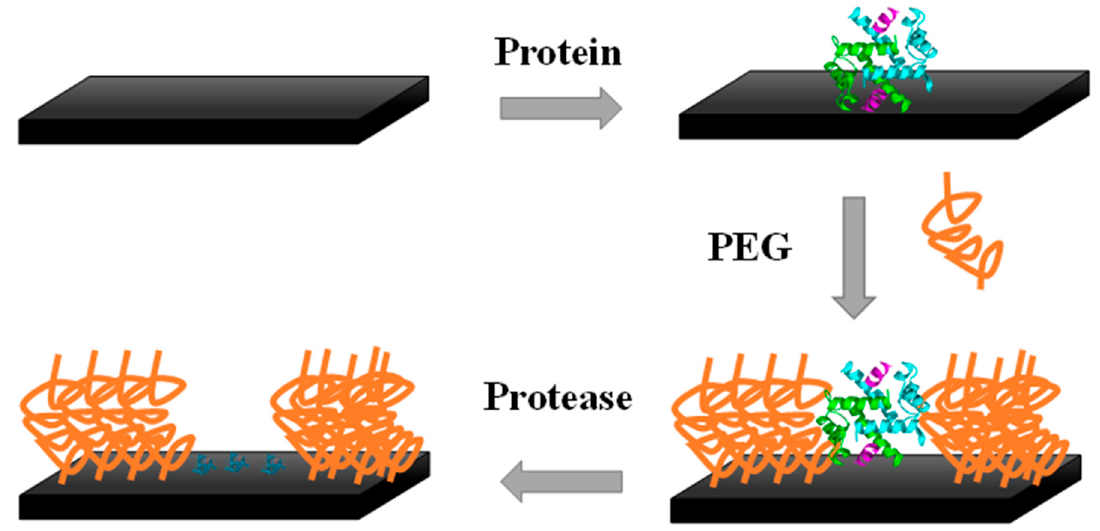
Figure 3. Polymer-brush imprinting.